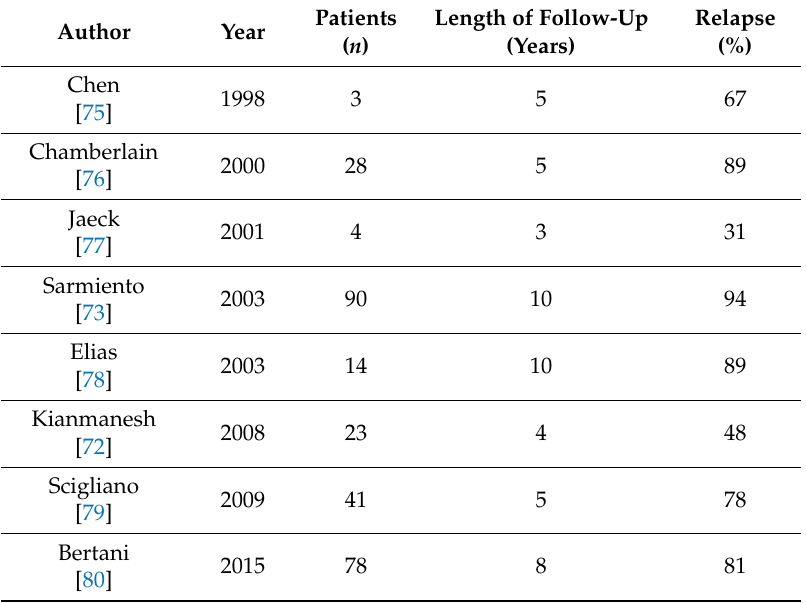
Table 2. Recurrence after radical liver surgery for neuroendocrine tumor (NET) liver